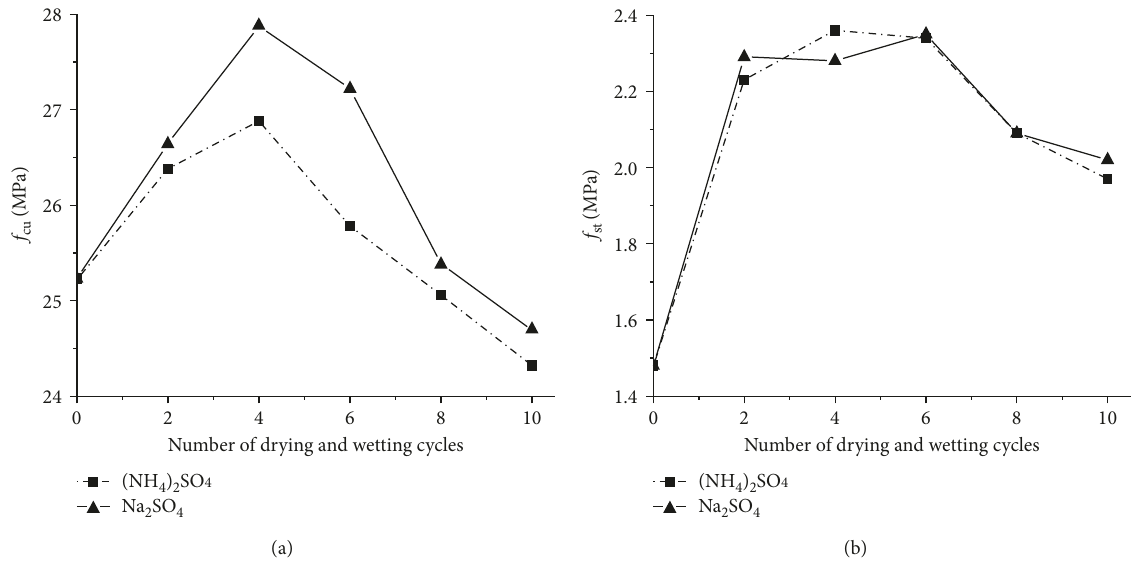
Figure 2: Changes in the strengths of corroded ordinary concrete varied to dry-wet cycles. (a) Compressive strength. (b) Splitting tensile strength.